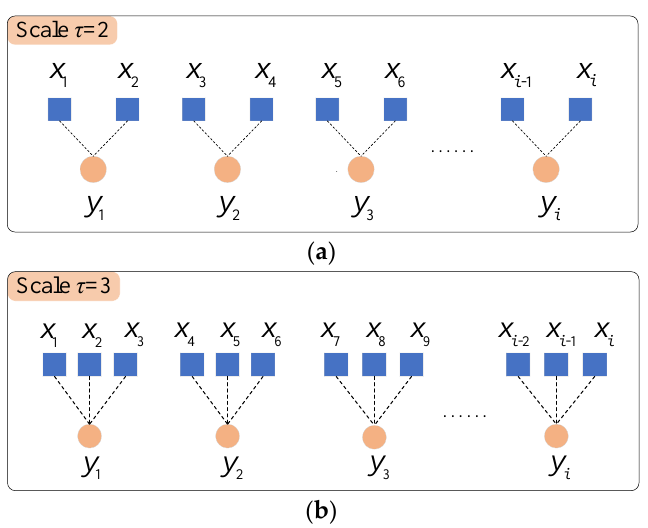
Figure 1. The illustration of conventional coarse-graining procedure: ( a ) 𝜏 is 2; ( b ) 𝜏 is 3.